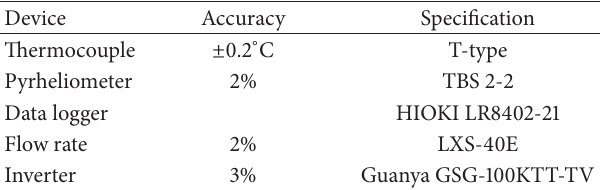
Table 2: Characteristics of sensors and measurement